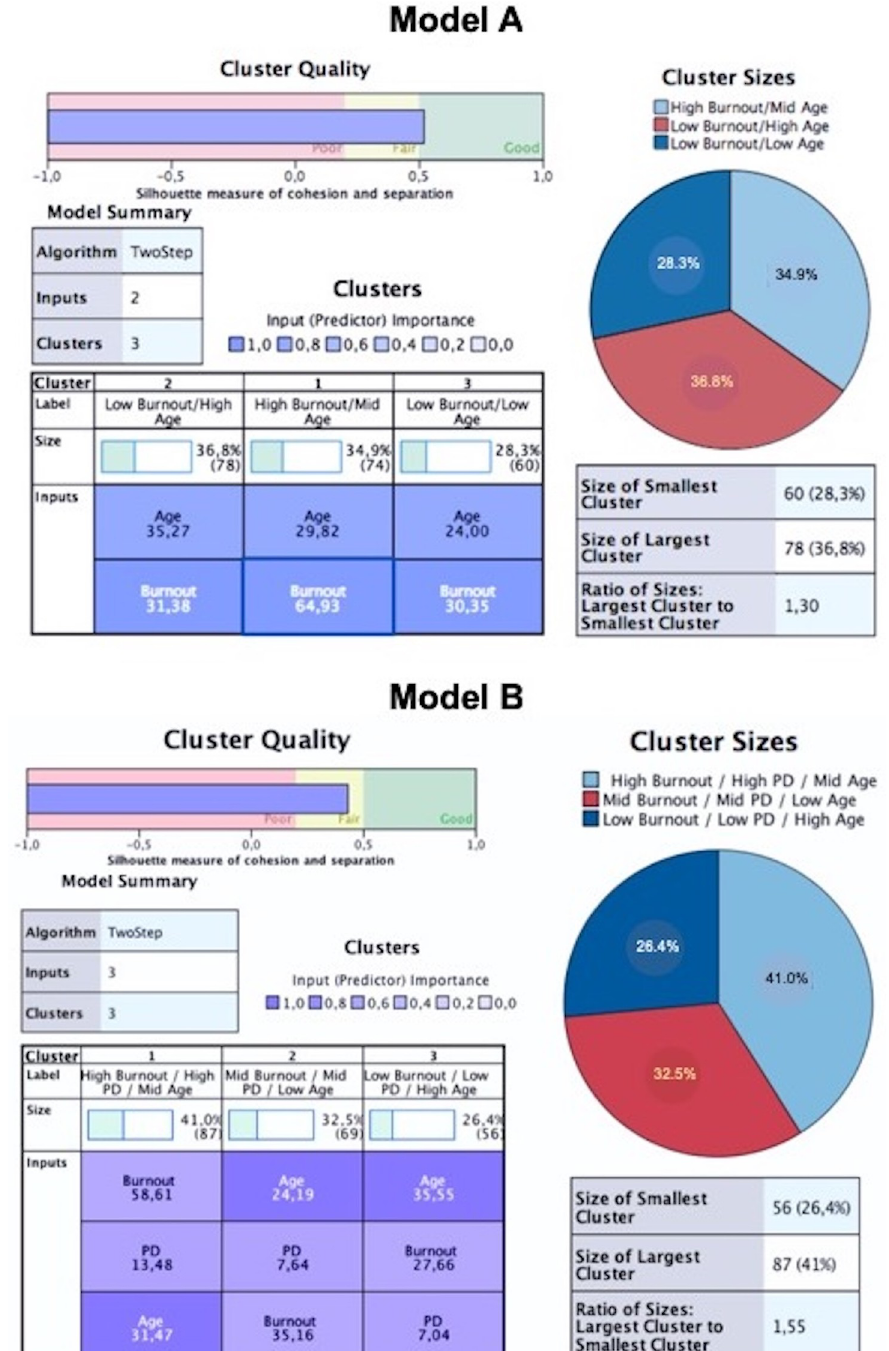
Fig 1. Cluster modelling. Detailed information for both Cluster Models. Variables included: Age (group), MBI-based burnout scores (Model A); Age (group), Psychological disturbance (PD) and MBI-based burnout scores (Model